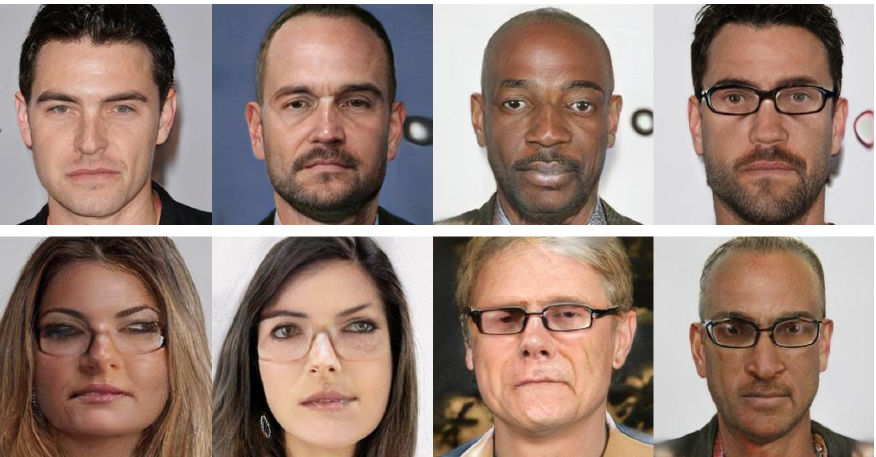
Figure 7. Artifacts present in synthetic images. ( Top ) Background artifacts of blob-like structure. ( Bottom ) Participants with glasses are not realistically